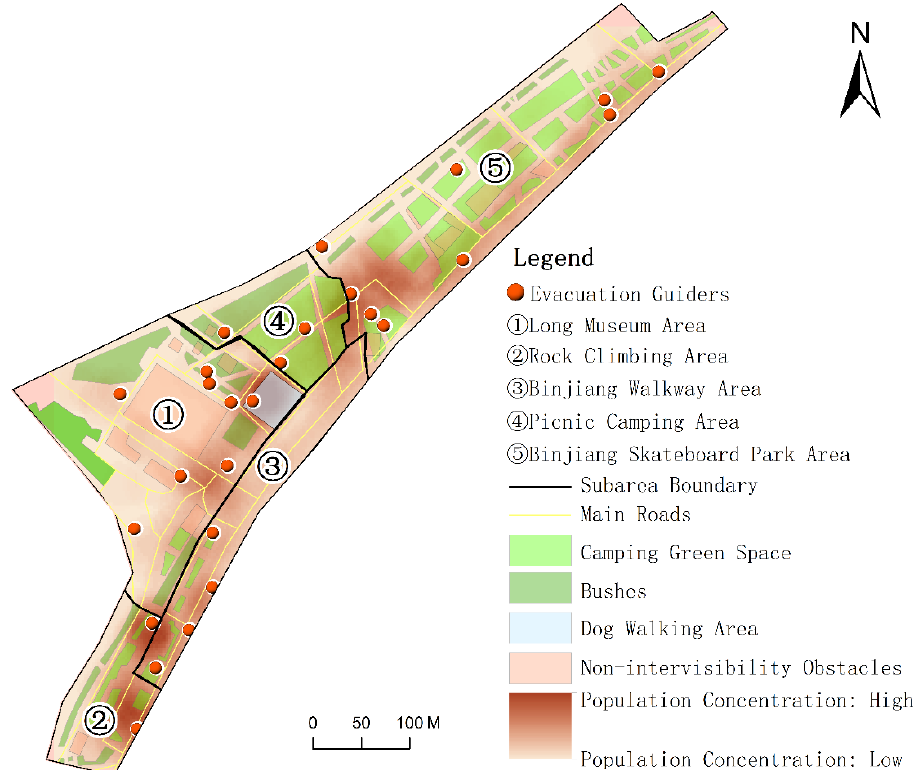
Figure 10. Spatial distribution of evacuees and spatial allocation of evacuation guiders at 17:00 on 5 May 2021.